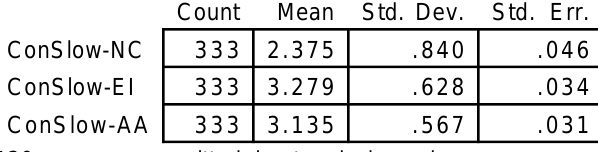
Don´t know 120 cases were omitted due to missing values.